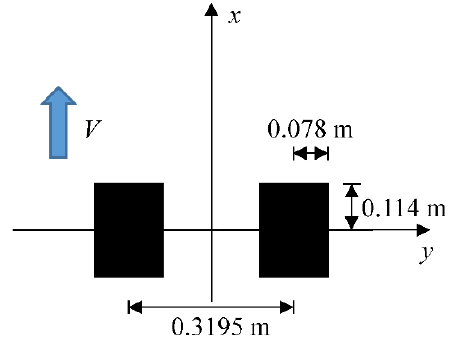
Figure 3. Double rectangular uniform moving load. Table 4. Mean values and standard deviations of random variables.